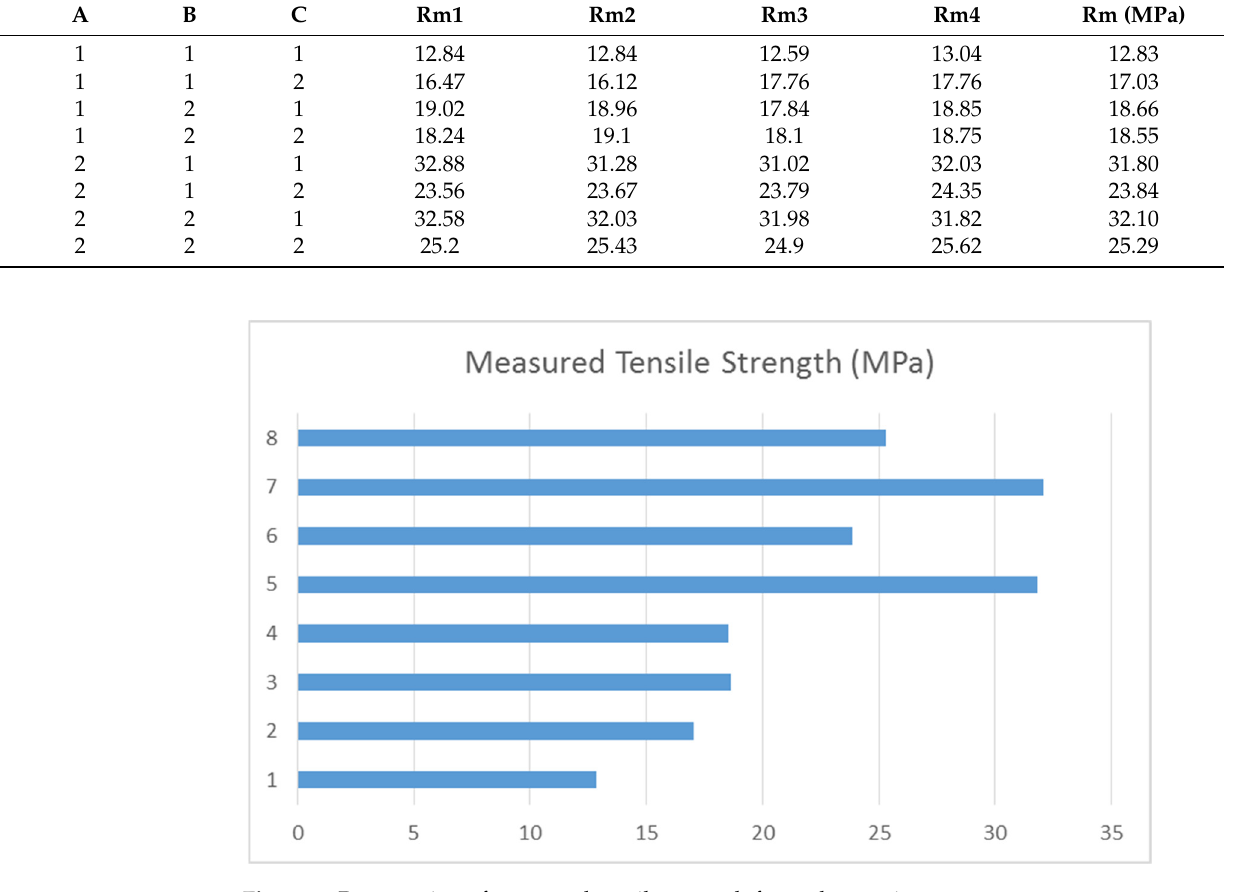
Table 6. ANOVA statistical evaluation output. FACTOR/ INTERACTIONS F (Calculated)